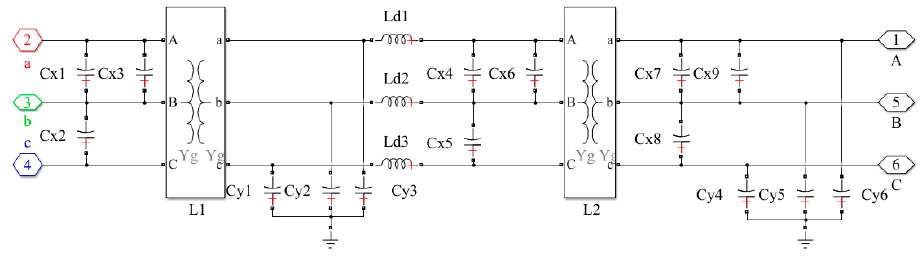
Figure 18. Circuit structure of two-stage filter in MATLAB.